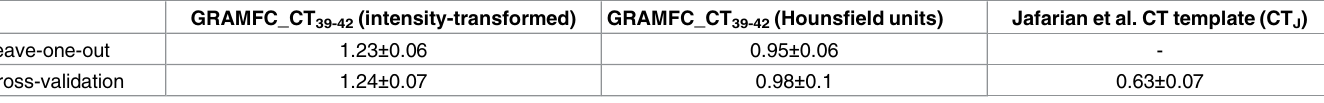
Table 1. Mutual information (Mean ± SD) between normalized images and neonatal CT templates. GRAMFC_CT 39-42 (intensity-transformed) GRAMFC_CT 39-42 (Hounsfield units) Jafarian et al. CT template (CT J ) Leave-one-out